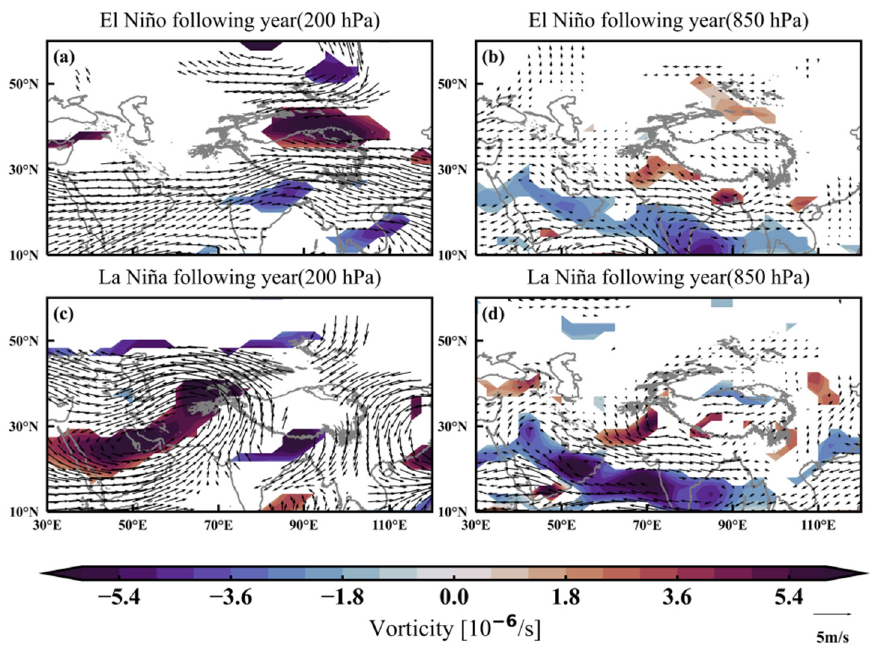
Figure 9. Simulation results of composite wind anomalies at 850 hPa and 200 hPa (arrows, unit: m/s), with the SAH region averaged (solid yellow lines, 12,520 gpm, geopotential height isolines), and relative-vorticity anomalies (shading, unit: 10 − 6 /s) in the summers following El Niño and La Niña. ( a ) El Niño at 200 hPa, ( b ) El Niño at 850 hPa, ( c ) La Niña at 200 hPa, ( d ) La Niña at 850 hPa. The results above the 95% confidence level ( t -test) are indicated.